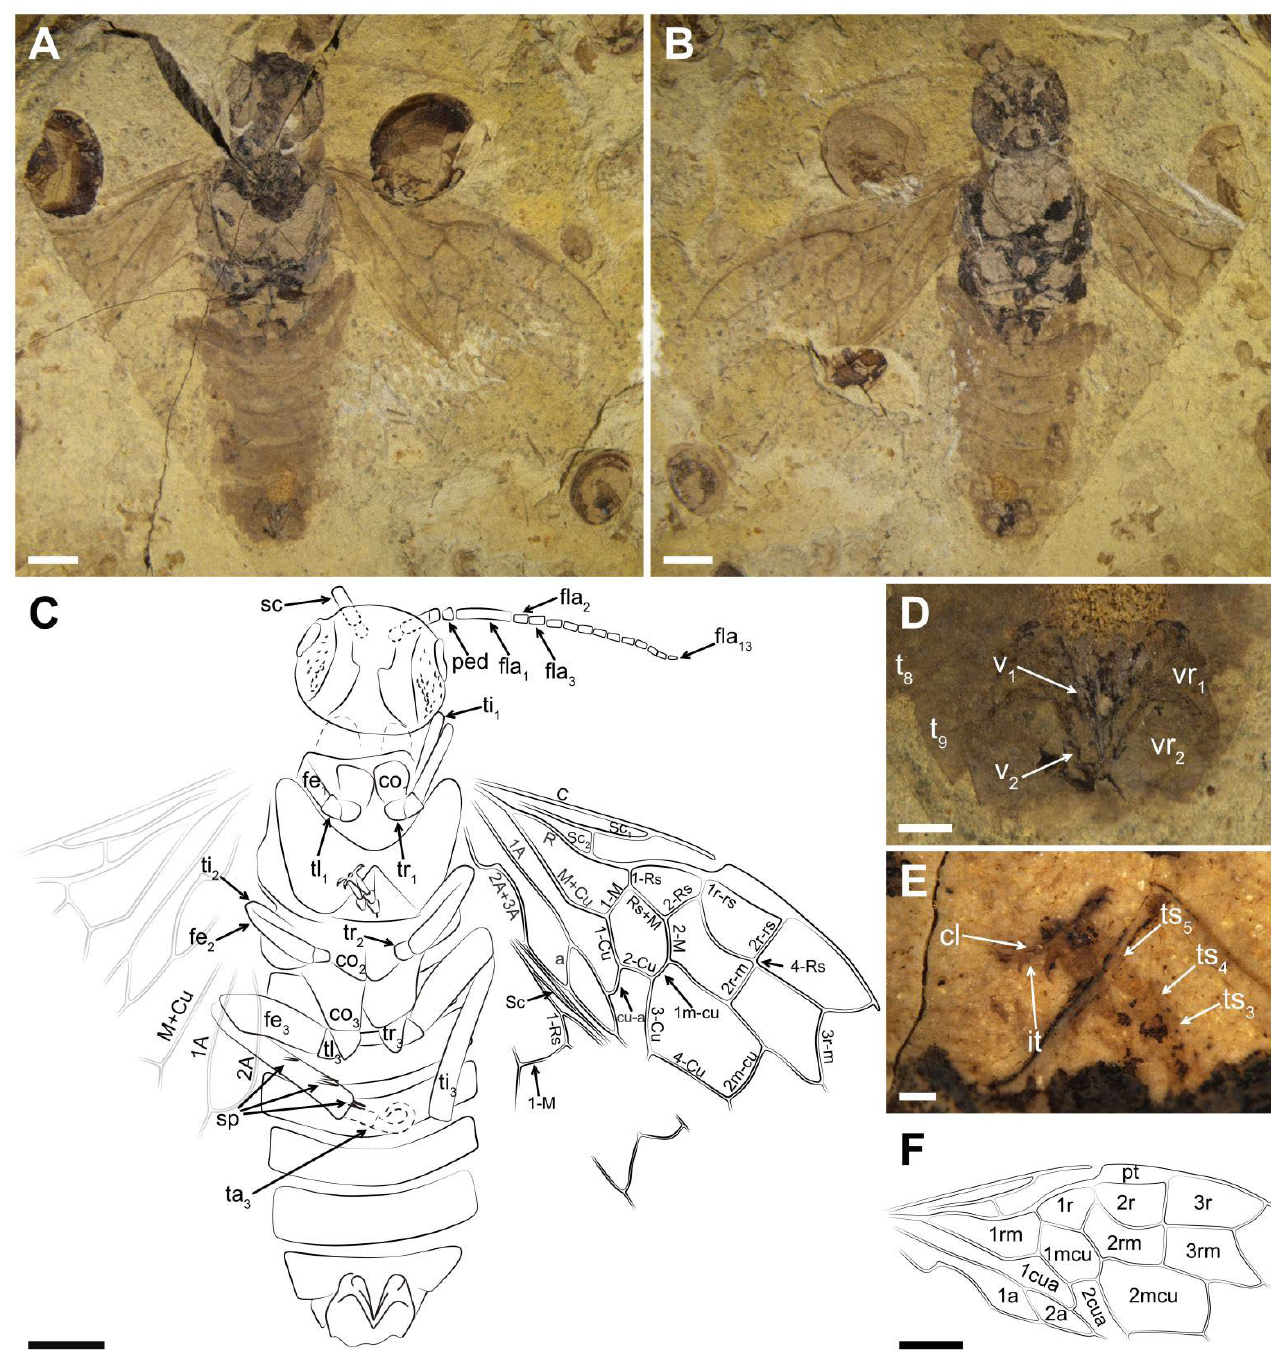
Figure 2. Scabolyda latusa sp. nov., Holotype (CNU-HYM-NN2022102p/c) female. Photo 2E was taken wetted with 95% ethanol. ( A ) Ventral view of body as preserved. ( B ) Dorsal view of body as preserved. ( C ) Line drawing of ventral view. ( D ) Ovipositor. ( E ) Mid tarsus. ( F ) Line drawing of forewing. Symbols: sc = scape; ped = pedicel; fla 1 , fla 2 , fla 3 , fla 13 = 1st, 2nd, 3rd, and 13th flagellomere; co 2 = mid coxa; tr 1 , tr 2 = fore and mid trochanter; tl 1 , tl 3 = fore and hind trochantellus; t 8 , t 9 = 8th and 9th tergum; v 1 , v 2 = 1st and 2nd valvifer; vr 1 , vr 2 = 1st and 2nd valvifer; it = inner tooth; pt = pterostigma. Scale bars: 2 mm in ( A – C , F ); 0.5 mm in D; 0.25 mm in ( E ).